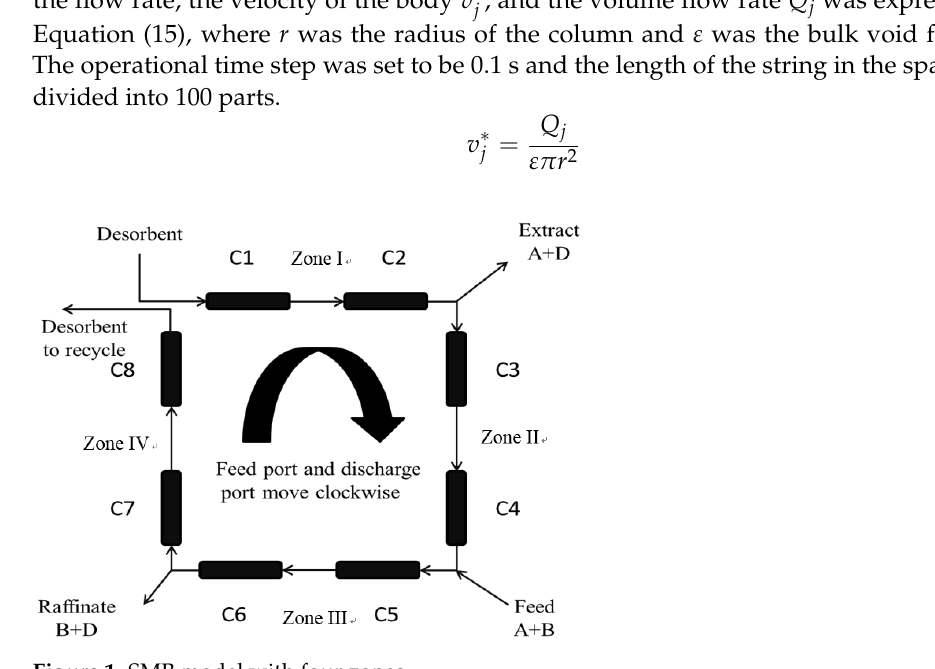
Figure 1. SMB model with four zones. Table 2. The initial parameters for the